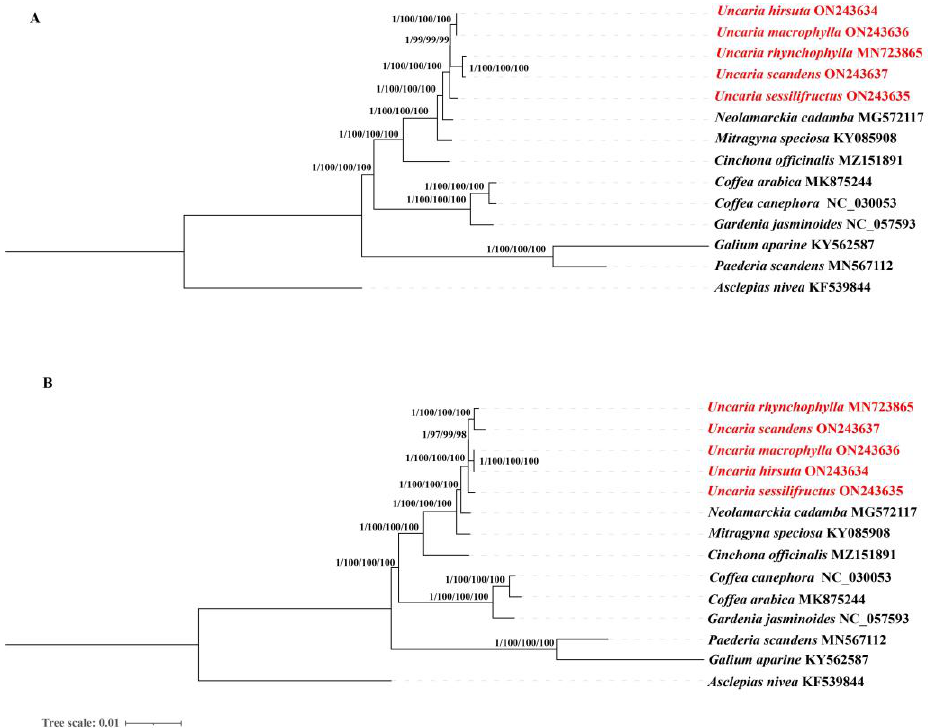
Figure 14. Phylogenetic trees based on 14 complete chloroplast genomes ( A ) and protein-coding genes ( B ) using different methods. From left to right, numbers above the branches are, respectively, represented Bayesian inference (BI) posterior probabilities (PPs) values, bootstrap support values of maximum likelihood (ML), neighbor-joining (NJ), and maximum parsimony (MP).